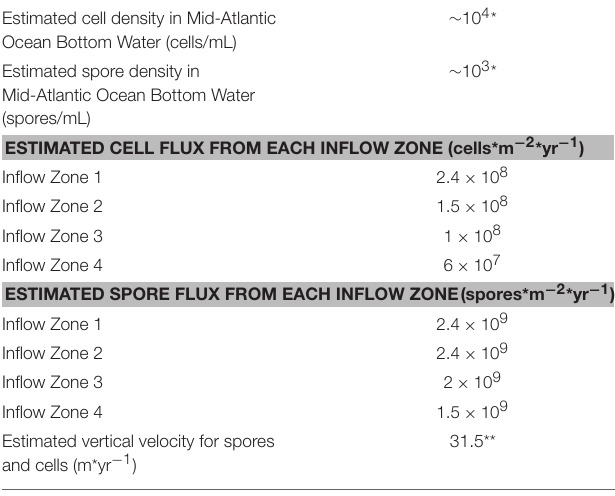
TABLE 1 | Assumptions used for calculating microbial transport model.